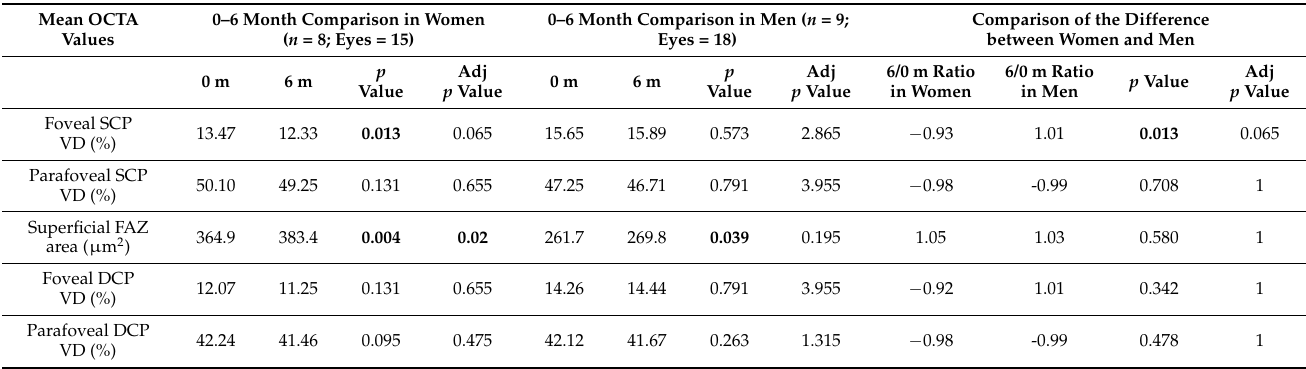
Table 3. Results from the 0–6 months prospective cohort study between women and men. Mean OCTA